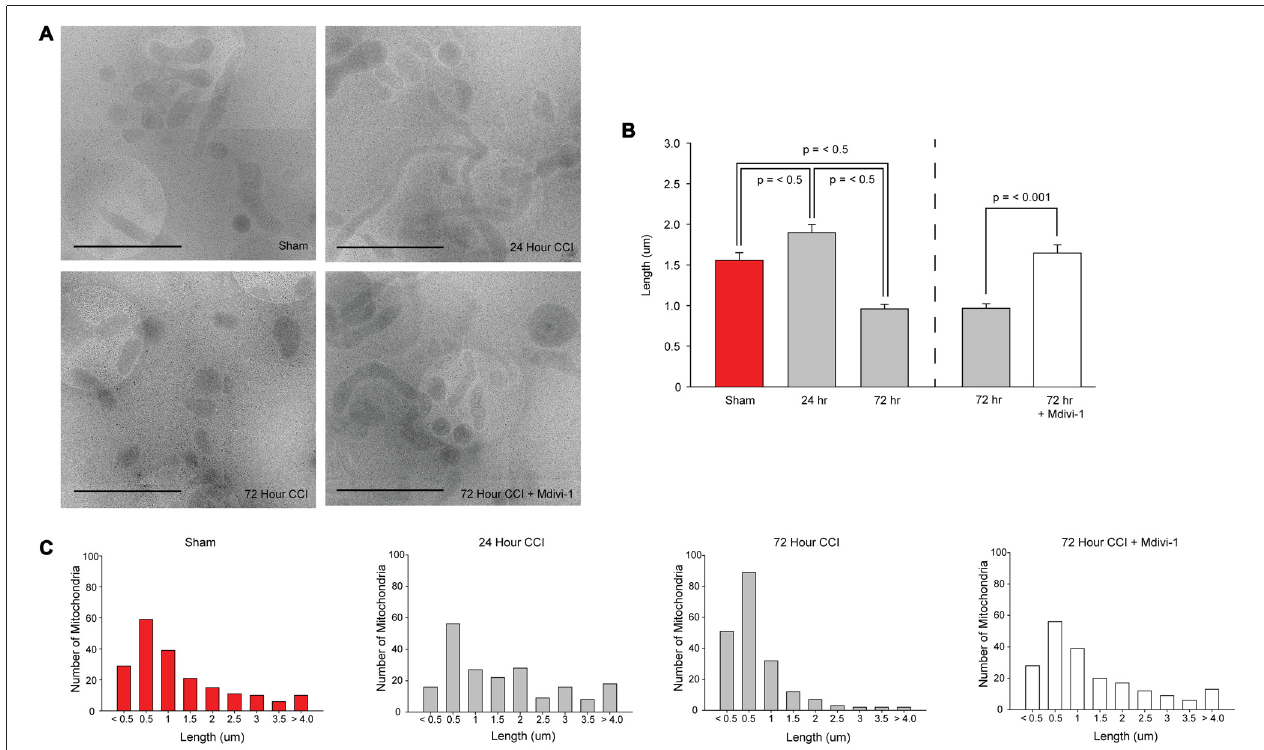
FIGURE 3 | CCI injury decreases mitochondrial length in the hippocampus that is blocked by Mitochondrial division inhibitor-1 (Mdivi-1). (A) Representative cryoEM micrographs of isolated hippocampal mitochondria from sham, 24 h post-CCI, 72 h post-CCI, and 72 h post-CCI + Mdivi-1. (B) Summary results for average mitochondrial length for each group. Please note, the results for the 72 h injured group are presented twice to represent the statistical comparisons to assess mitochondria length over time after injury, and to assess the effect of Mdivi-1 at 72 h. (C) Population distributions of hippocampal mitochondrial lengths from sham, 24 h post-CCI, 72 h post-CCI, and 72 h post-CCI + Mdivi-1 animals. Lengths were binned (bin sizes of 500 nm) and the number of mitochondria per bin are shown. X -axis labels indicate the lower bin value for each bin range. Data are presented as the mean ±